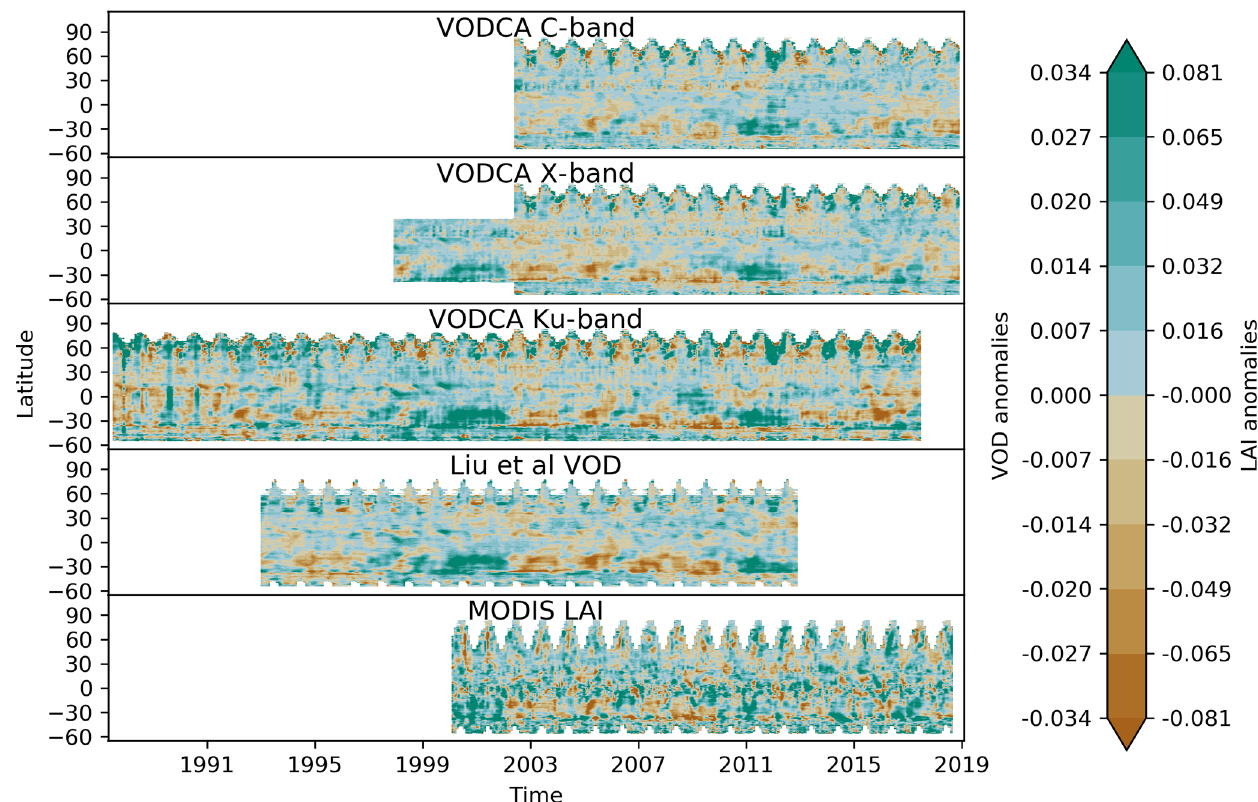
Figure 6. Hovmöller diagrams showing anomalies of the monthly means per latitude for each band of VODCA and VOD_Liu and for